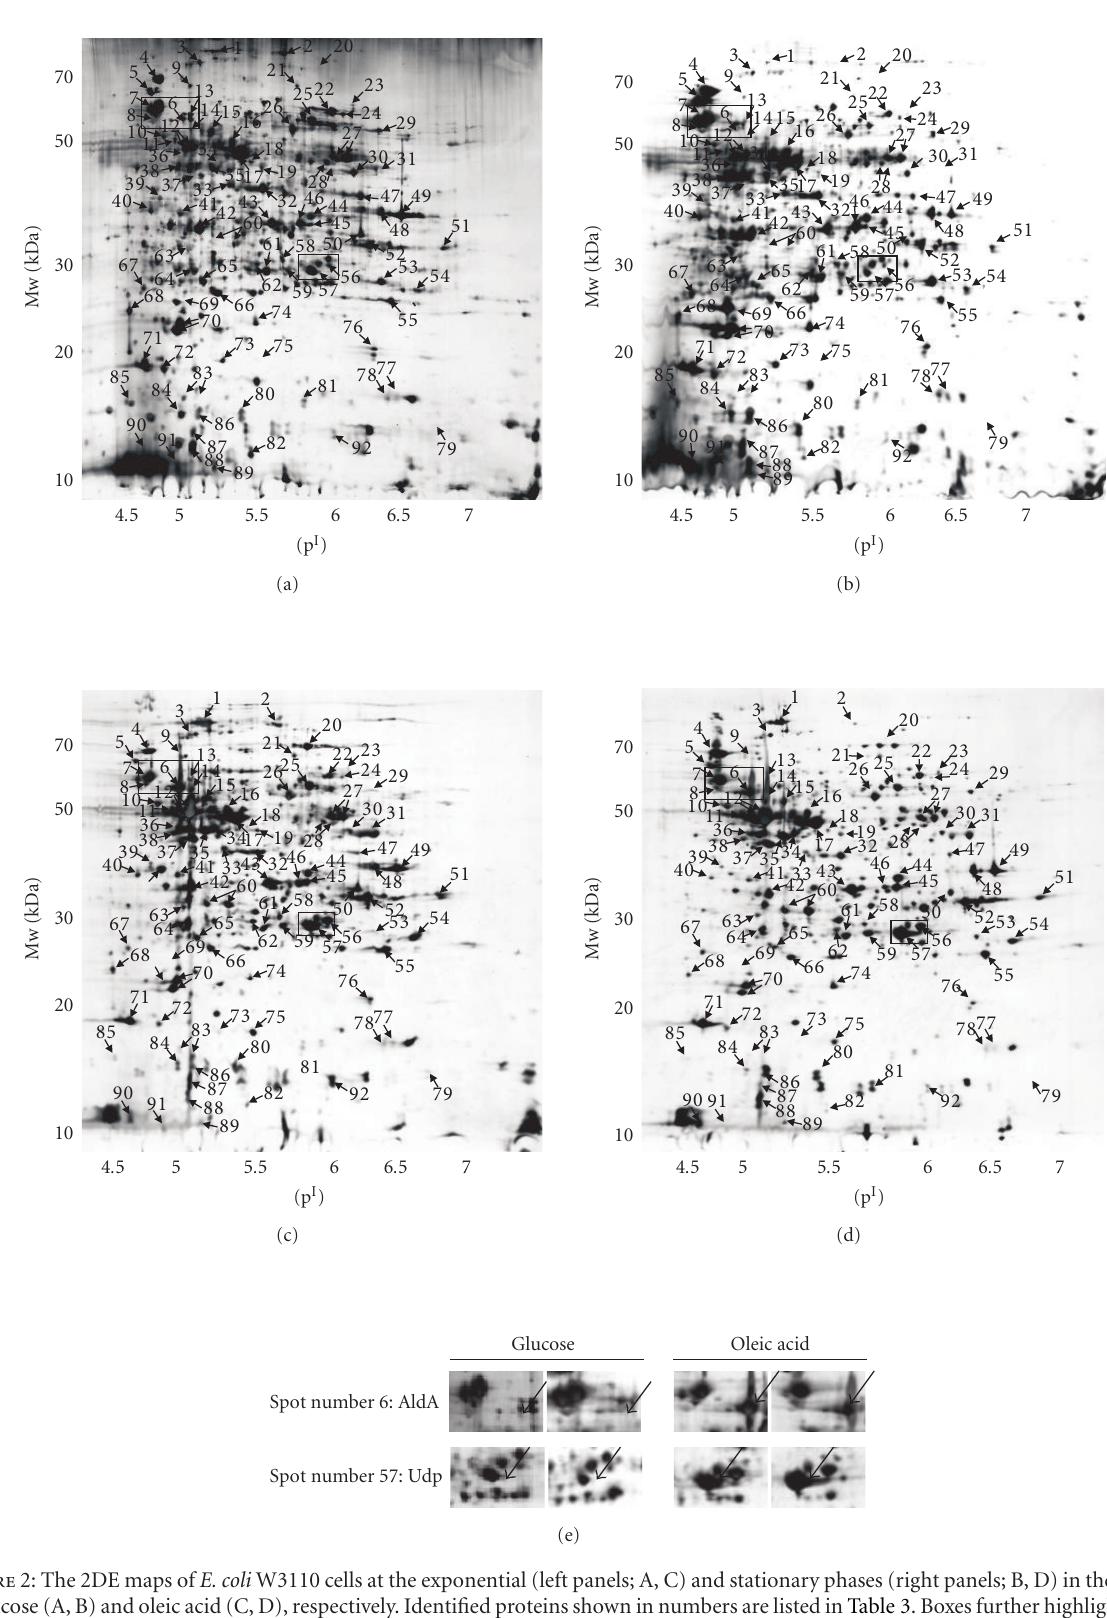
Figure 2: The 2DE maps of E. coli W3110 cells at the exponential (left panels; A, C) and stationary phases (right panels; B, D) in the presence of glucose (A, B) and oleic acid (C, D), respectively. Identified proteins shown in numbers are listed in Table 3. Boxes further highlight specific corresponding regions of the 2D gel images, which are compared at higher resolution in the bottom of (E). Arrow lines indicate individual spots of AldA and